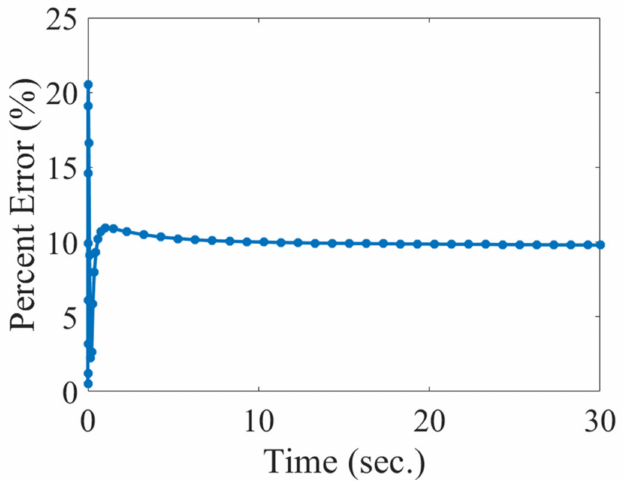
Figure 7. Estimated error between the average cavity temperature and the thermistor measured